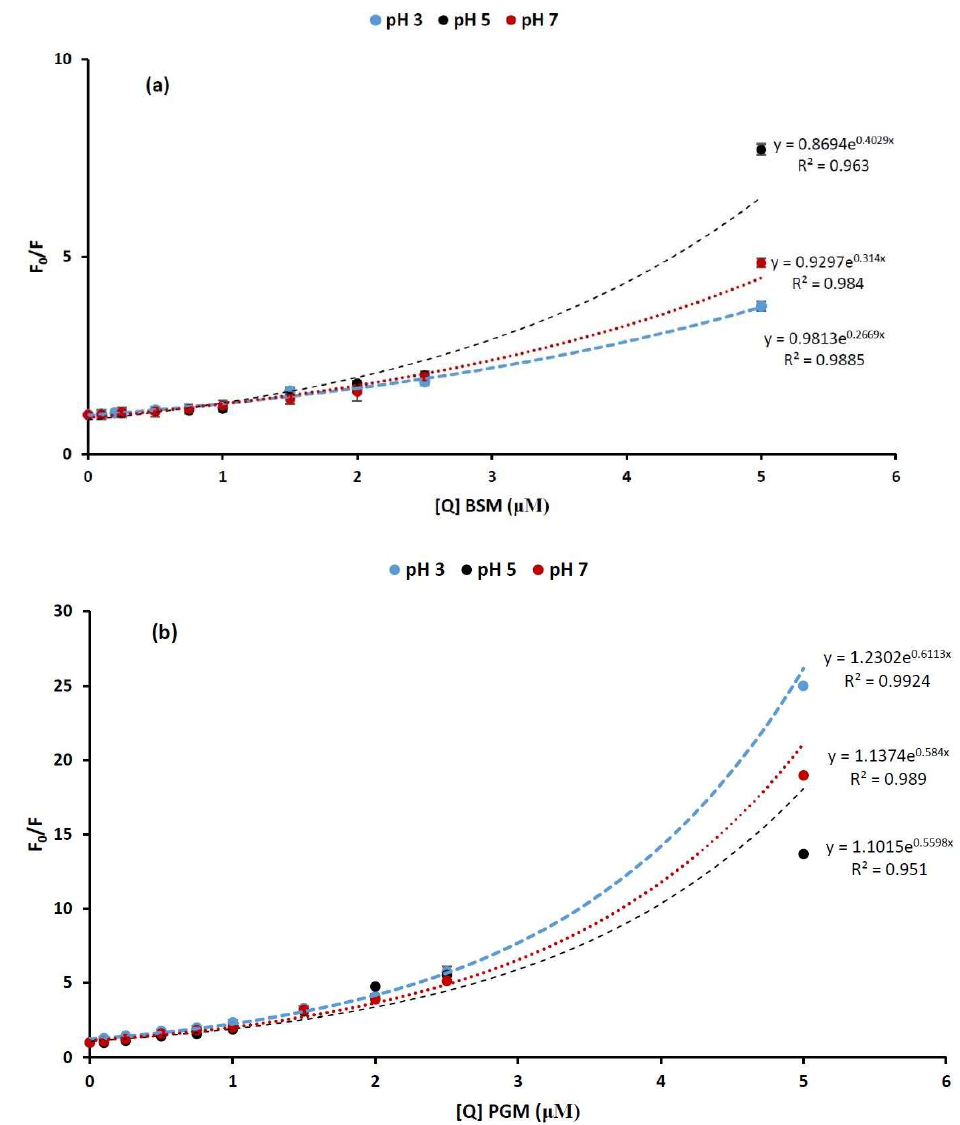
Figure 3. Stern–Volmer plots describing tryptophan quenching of β-lactoglobulin (28 μM) by increasing concentration of ( a ) bovine submaxillary mucin (BSM) and ( b ) porcine gastric mucin (PGM) in different pH values of phosphate buffer solutions (blue: pH = 3, black: pH = 5, red: pH = 7). The fluorescence emission intensity was recorded at λ ex 280 nm and the λ em maximum occurred at 326 nm.